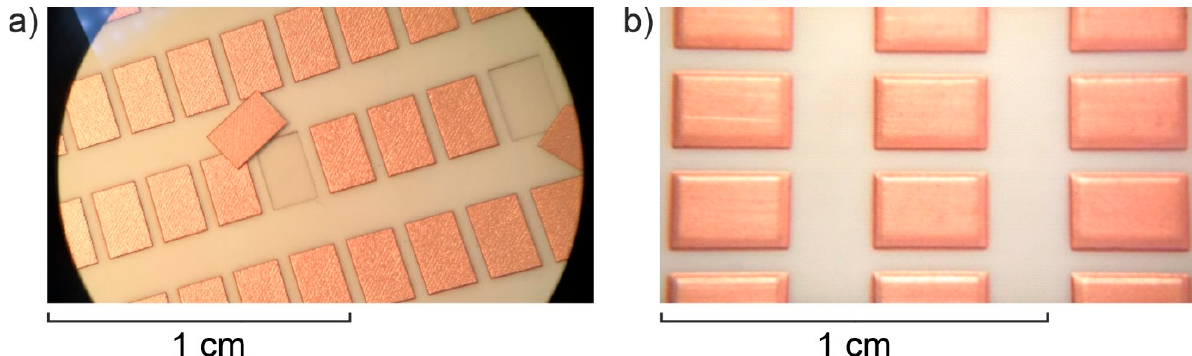
Figure 5. Images of copper film deposited on alumina substrate: ( a ) in the laser-engraved cavities; ( b ) on a planar substrate through a shadow mask.